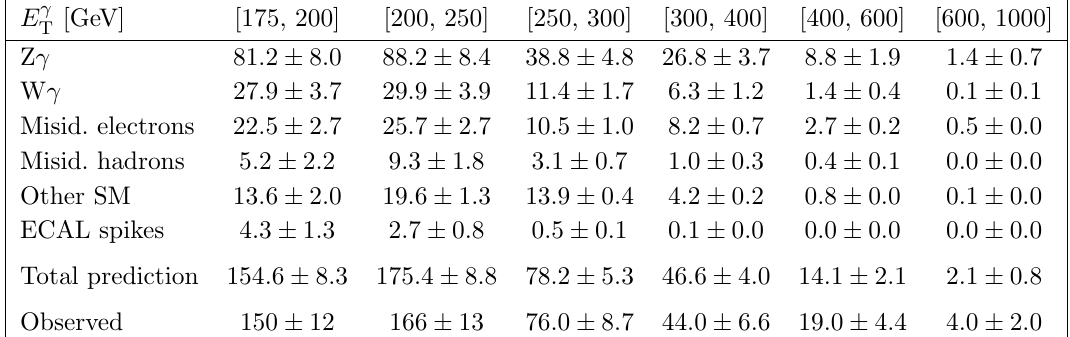
Table 1 . Expected event yields in each E (cid:13) bin for various background processes in the horizontal T signal region. The background yields and the corresponding uncertainties are obtained after per- forming a combined (cid:12)t to data in all the control samples, excluding data in the signal region. The observed event yields in the horizontal signal region are also